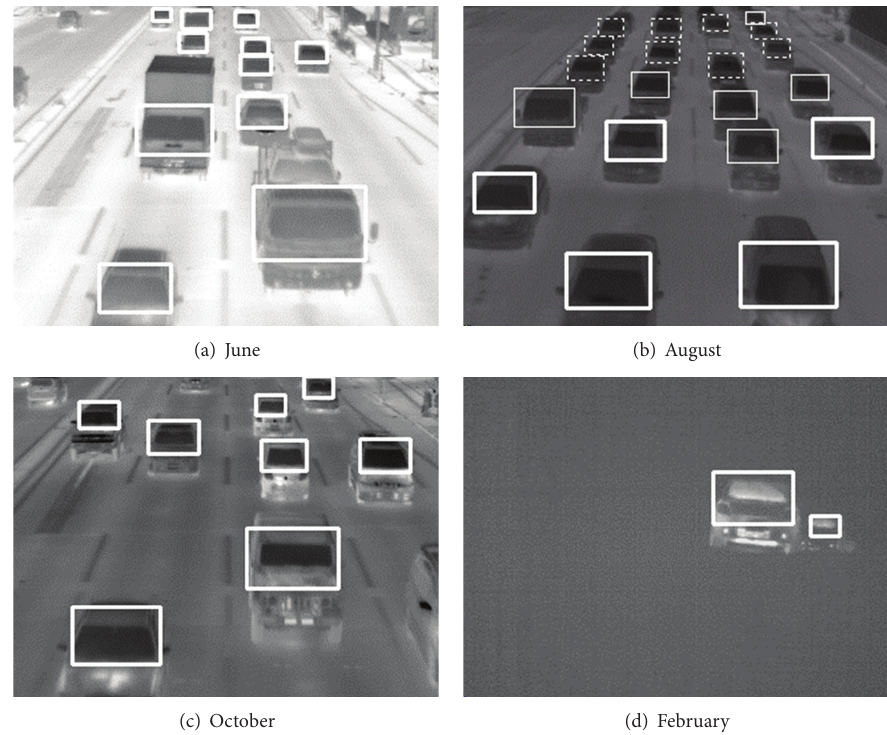
Figure 4: Some vehicle detection results by method 1.